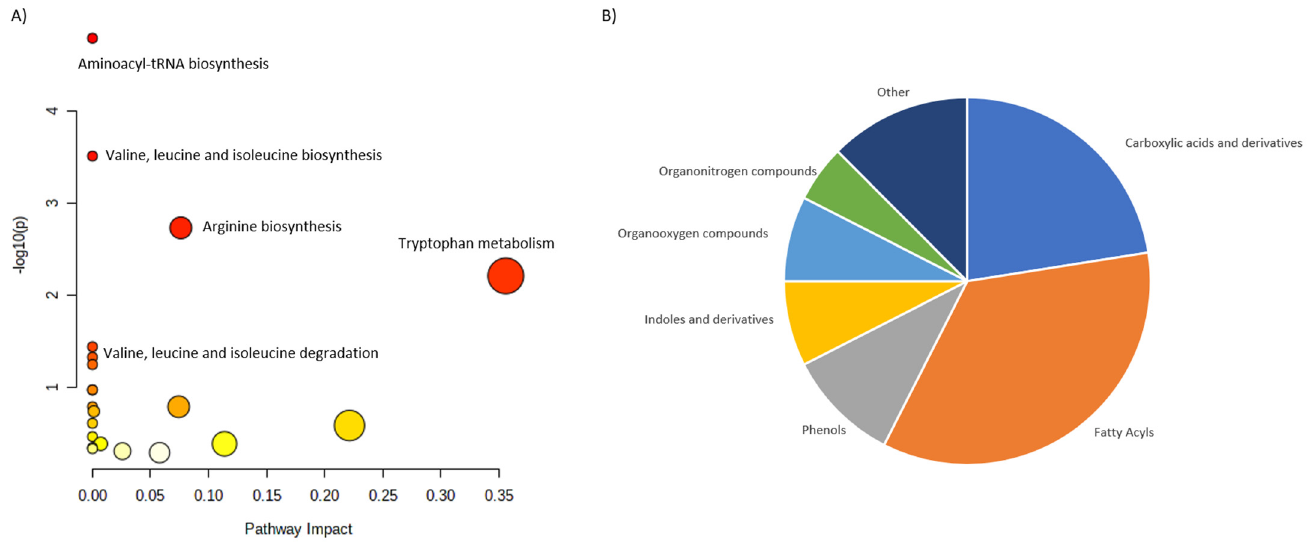
Figure 6. Characterization of metabolites altered in vitamin D3 deficiency. ( A ) shows the main pathways, built for the discriminating metabolites reported in review publications. ( B ) shows pie chart, illustrating the distribution of the discriminating metabolites across different metabolite classes. Second largest group of metabolites are Carboxylic acids and derivatives, followed by Phenols, Indoles and derivatives and Organooxygen compounds. The location of these metabolites in the metabolic pathways showed high alterations in the amino acids’ metabolism. Tryptophan metabolism, Arginine biosynthesis and Valine, leucine and isoleucine biosynthesis together with Amino-tRNS biosynthesis were the most impacted